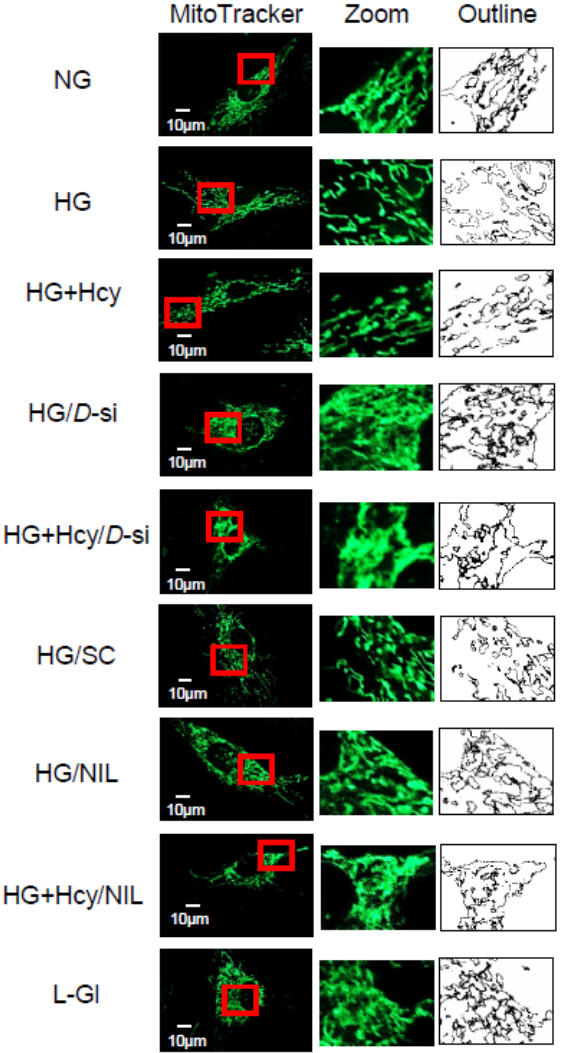
Figure 2. Effect of homocysteine on glucose-induced mitochondrial fission. Live-cell microscopy was performed on HRECs plated on coverslips using 200 nM MitoTracker green dye. The coverslips were imaged under a ZEISS Apotome microscope using a 40 × objective. Enlarged area inside the box is shown in the middle panel, and the bare outlines, drawn to illustrate the morphology, are in the right panel. The image is representative of 3–4 different experiments, with each experiment performed in 6–8 cells: NG and HG, cells in normal and high glucose, respectively; HG + Hcy, cells in high glucose and homocysteine; HG/ D -si and HG + Hcy/ D -si, Drp1 -siRNA transfected cells in high glucose or high glucose + homocysteine, respectively; HG/SC, nontargeting scrambled RNA transfected cells in high glucose; HG/NIL and HG + Hcy/NIL, cells in the presence of NIL in high glucose or high glucose + homocysteine, respectively; L-Gl, 20 mM L-glucose.